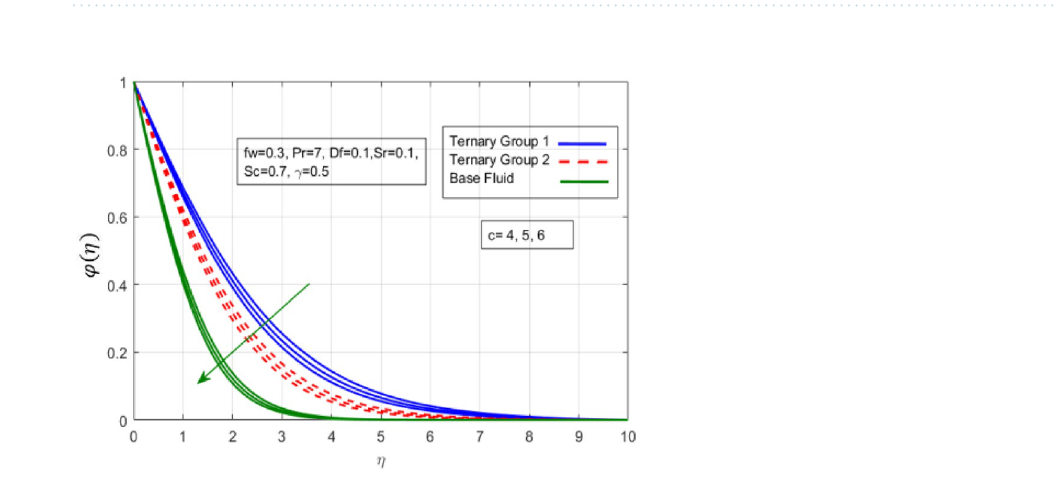
Figure 8. Variation in concentration against stretching ratio